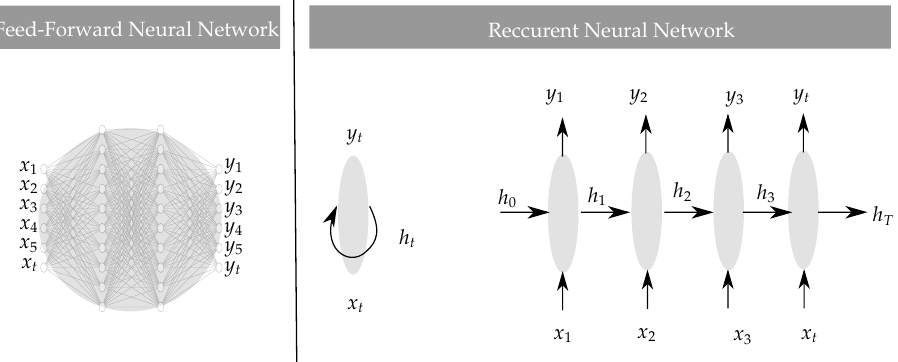
Figure 3. Feed-Forward Neural Networks (FNN) in comparison to Recurrent Neural Networks (RNN).